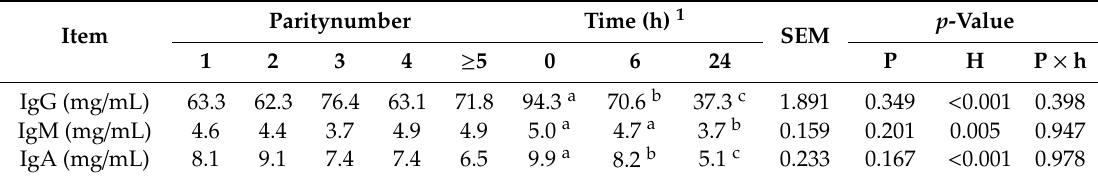
Table 4. E ff ect of parity number and time since farrowing on IgG, IgM and IgA concentrations in Large-White × Landrace sow colostrum.